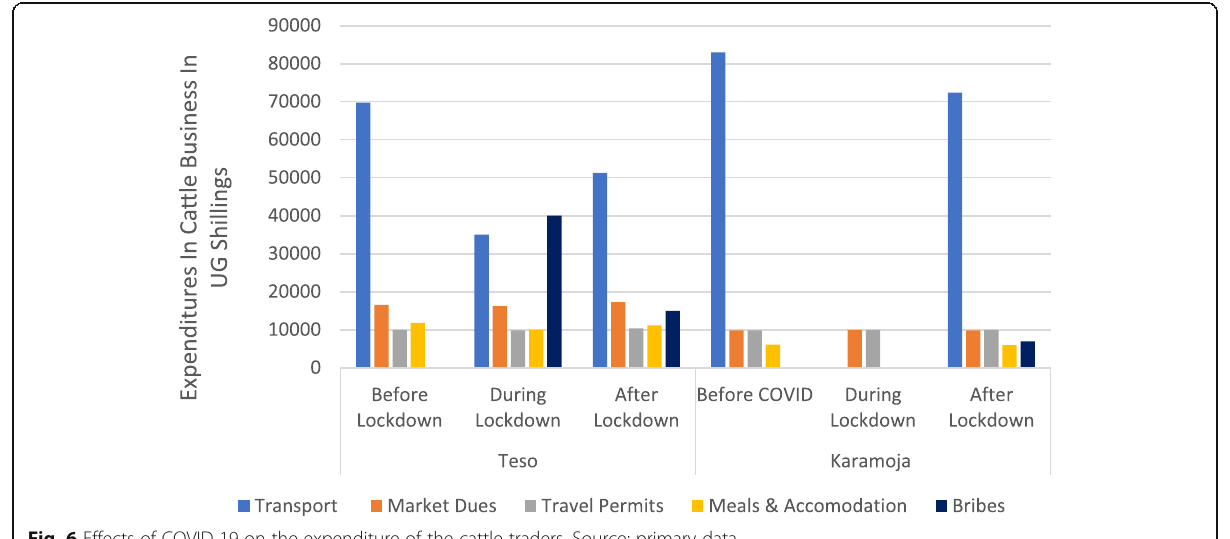
Fig. 6 Effects of COVID-19 on the expenditure of the cattle traders. Source: primary